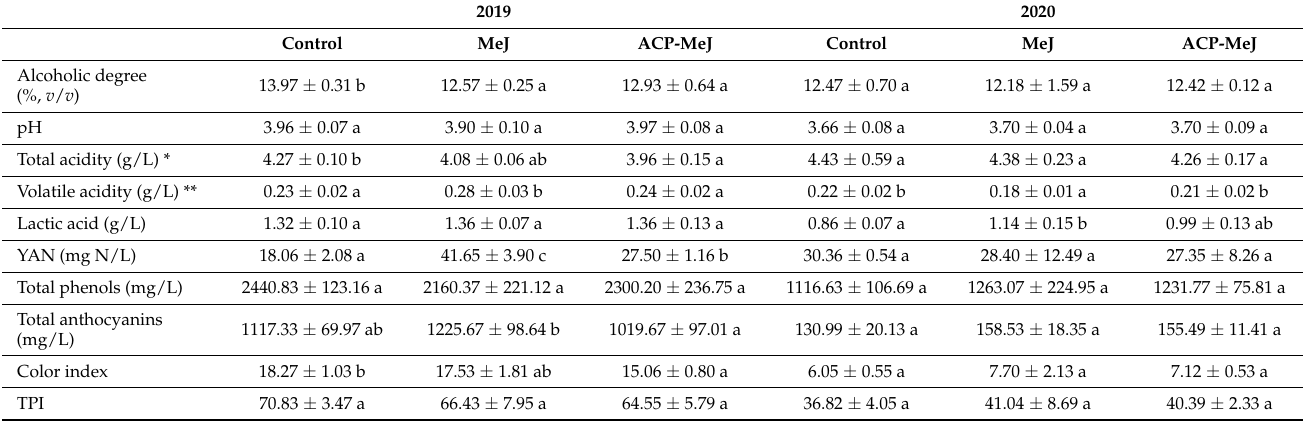
Table 1. Basic enological parameters in wines from control, methyl jasmonate (MeJ) and nanoparticles doped with this elicitor (ACP-MeJ) treatments, in 2019 and 2020